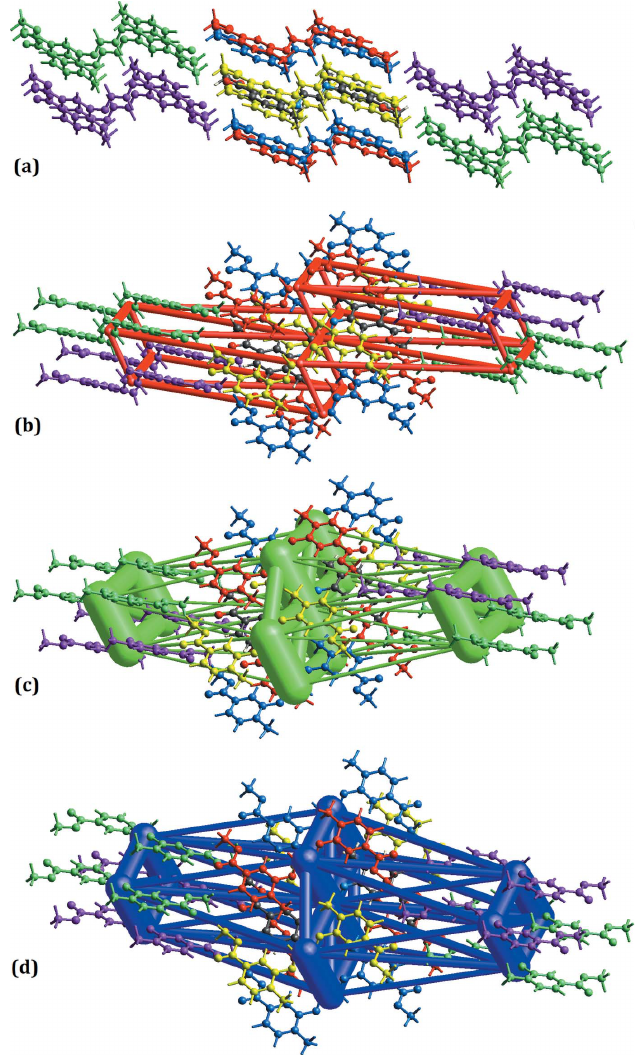
Figure 6 Intermolecular interaction energies: ( a ) Color coding of neighboring molecules with respect to the central molecule (gray), ( b ) Coulombic, ( c ) dispersion and ( d ) total interaction energy for the title compound.